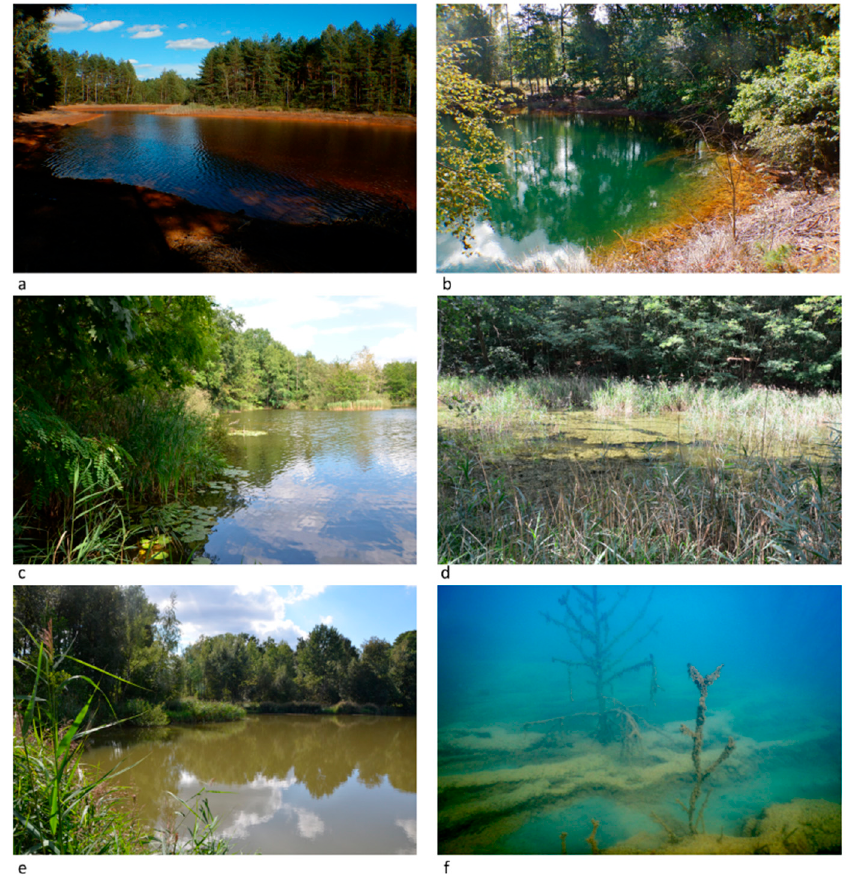
Figure 4. Examples of the investigated lakes: ( a ) an early stage lake (reddish-brown, extreme acidity, high mineralization with extreme iron content, no vegetation), ( b ) an early stage lake (clear water, turquoise color, very high acidity, lower iron content, monodominant species stands composed of hydrophytes), ( c ) a transitional stage lake (relatively low acidity, lower mineralization, higher nutrient content, well-developed stripe-like vegetation), ( d ) a late stage lake (neutral acidity, low hardness, high nutrient concentration, macrophyte overgrowth processes), ( e ) a degraded lake (neutralization with lime, fertilization with sewage, lack of hydrophytes as a consequence of carp stocking), ( f ) a sinkhole lake with a dead bottom zone and visible concentrations of hydrogen sulfide (dead trees—evidence of an earlier, terrestrial stage).